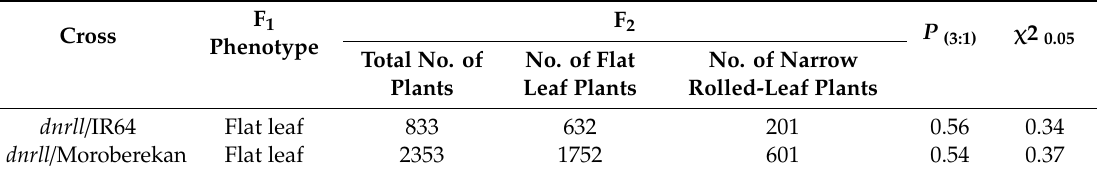
Table 1. Genetic control of the narrow-rolled leaf trait in dnrl1 .